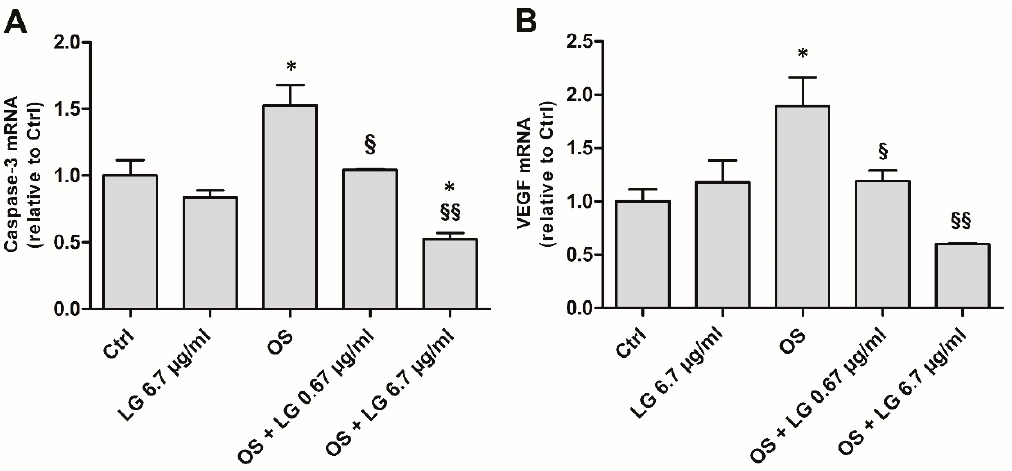
Figure 1. Caspase-3 ( A ) and vascular endothelial growth factor (VEGF), B ) mRNA expressions evaluated with qPCR in ex vivo retinal explants cultured for 5 days in control (Ctrl) conditions, in the presence of 6.7 µ g/mL Lisosan G (LG), or in oxidative stress (OS) with LG at 0.67 or 6.7 µ g/mL. Each column represents mean ± SD. * p < 0.05 vs. Ctrl; § p < 0.05 vs. OS; §§ p < 0.01 vs. OS; n = 3. Power value: 0.88 and 0.81, respectively.